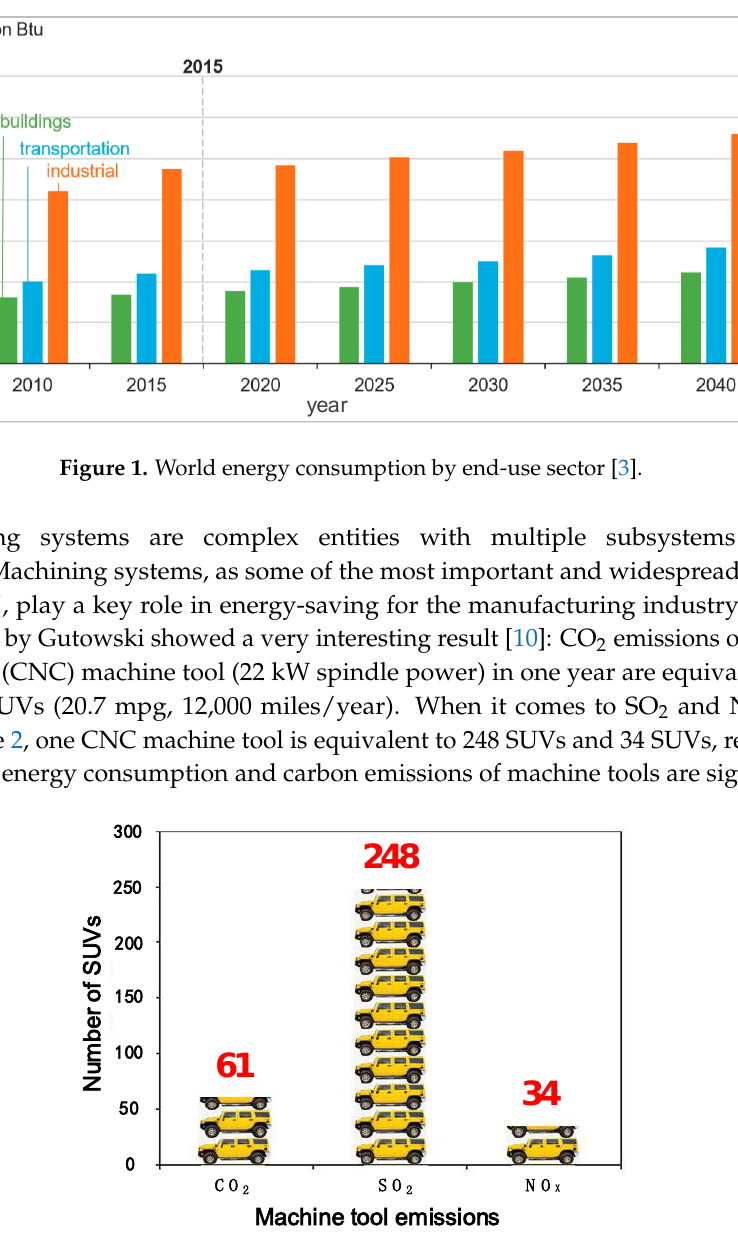
Figure 2. Machine tool emissions compared with SUVs [10].